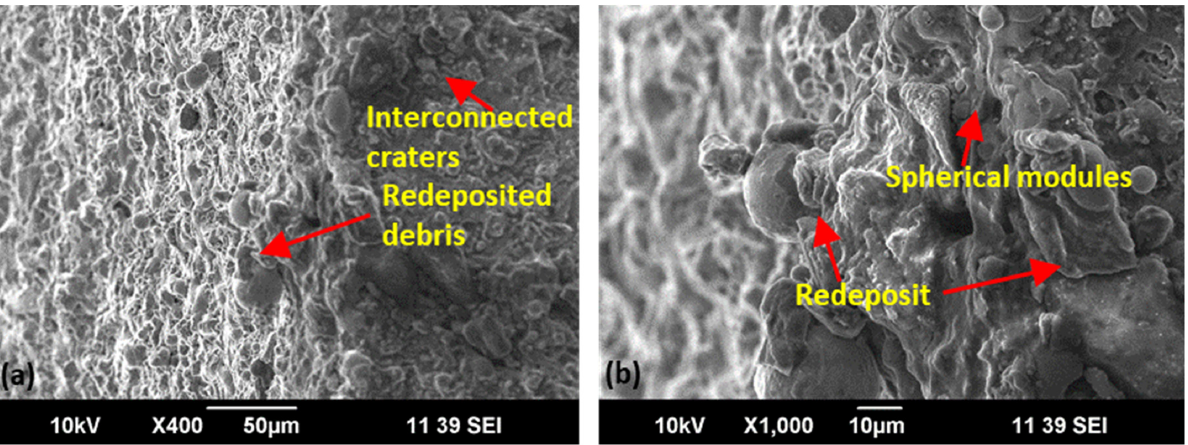
Figure 16. Scanning electron microscopic analysis of concave geometry for optimal parametric set- ting (V S 50 V, F P 4 kg/cm 2 , Ø N 8 mm, and W D 10 mm) at X400 ( a ) and X1000 ( b ). (V S 50 V, F P 4 kg/cm 2 , Ø N 8 mm, and W D 10 mm) at × 400 ( a ) and × 1000 ( b ).